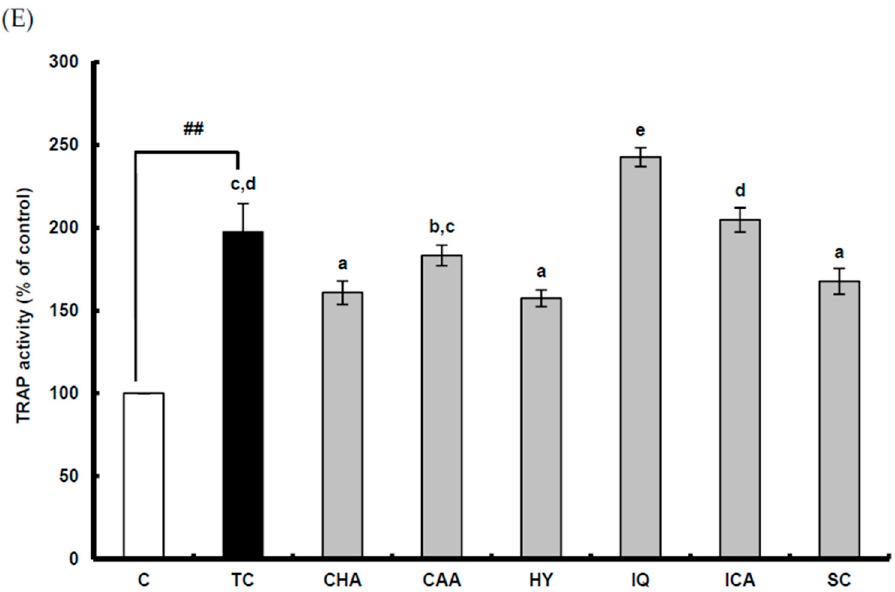
Figure 3. Inhibitory effect of hydroethanolic extract of A. capillaris and its six marker compounds on osteoclast differentiation. ( A ) The visualized tartrate-resistant acid phosphatase (TRAP)-positive multinucleated osteoclasts with A. capillaris hydroethanolic extract (ACHE) treatment; ( B , C ) The counted number and TRAP activity of TRAP-positive multinucleated osteoclasts with ACHE treatment; ( D ) The cytotoxicity of A. capillaris and its six marker compounds; ( E ) The TRAP activity of multinucleated osteoclasts with six marker compounds treatment. RAW 264.7 cells were exposed to receptor activator of nuclear factor- κ B ligand (RANKL; 50 ng/mL) for 5 days in the absence and presence of ACHE. After 5 days in culture, the cells were fixed and stained using a leukocyte acid phosphatase kit. TRAP-positive multinucleated osteoclasts were visualized at 200-fold magnification under light microscopy. TRAP-positive multi-nucleated osteoclasts were counted and TRAP activity was measured at λ = 405 nm. Data are expressed as percentages of the value of cells treated with RANKL (means ± standard deviations, SD, n = 3). Data are expressed as percentages of the values of untreated cells (means ± standard deviations, n = 3). Different corresponding letters indicate significant differences at p < 0.05 by Duncan’s test. ## p < 0.01, ### p < 0.001 vs. C. C: control, which was